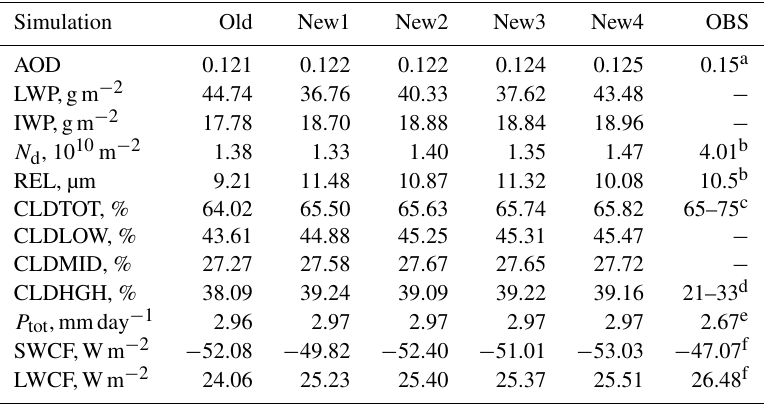
Table 2. Annual global mean aerosols, cloud properties, and surface precipitation, as well as the the top of atmosphere (TOA) energy budget with year 2000 aerosol emissions including aerosol optical depth at wavelength 550nm (AOD), liquid water path (LWP), ice water path (IWP), the vertical integrated cloud droplet number concentration ( N d ), cloud-top effective radius (REL), total cloud fraction (CLDTOT), low cloud fraction (CLDLOW), middle cloud fraction (CLDMID), high cloud fraction (CLDHGH), total precipitation rate ( P tot ), shortwave cloud radiative forcing (SWCF), and longwave cloud radiative forcing (LWCF). Simulation Old New1 New2 New3 New4 OBS AOD